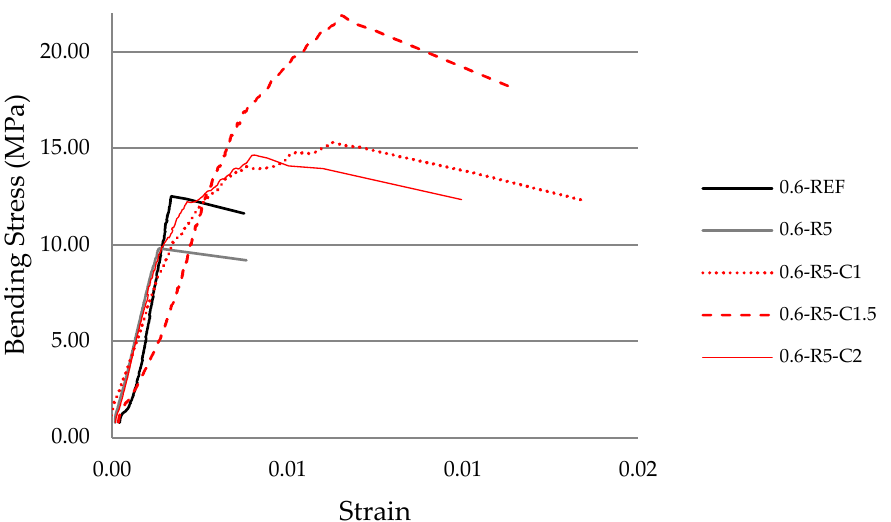
Figure 7. Experimental stress–strain relationship in bending tests on prismatic samples of the different mortar mixes (w/g 1 0.6).